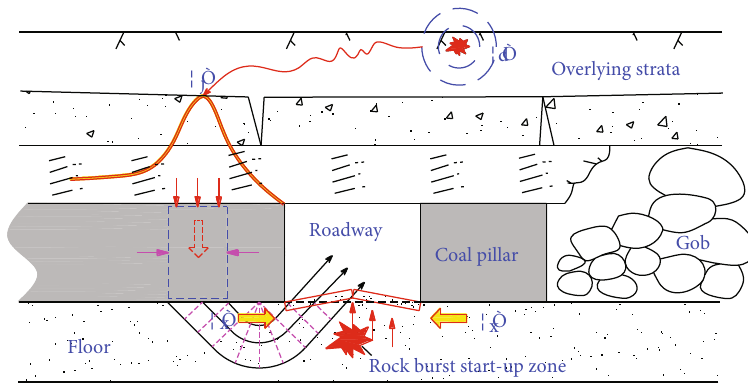
Figure 8: The occurrence mechanism schematic diagram of rock burst in roadway fl oor.